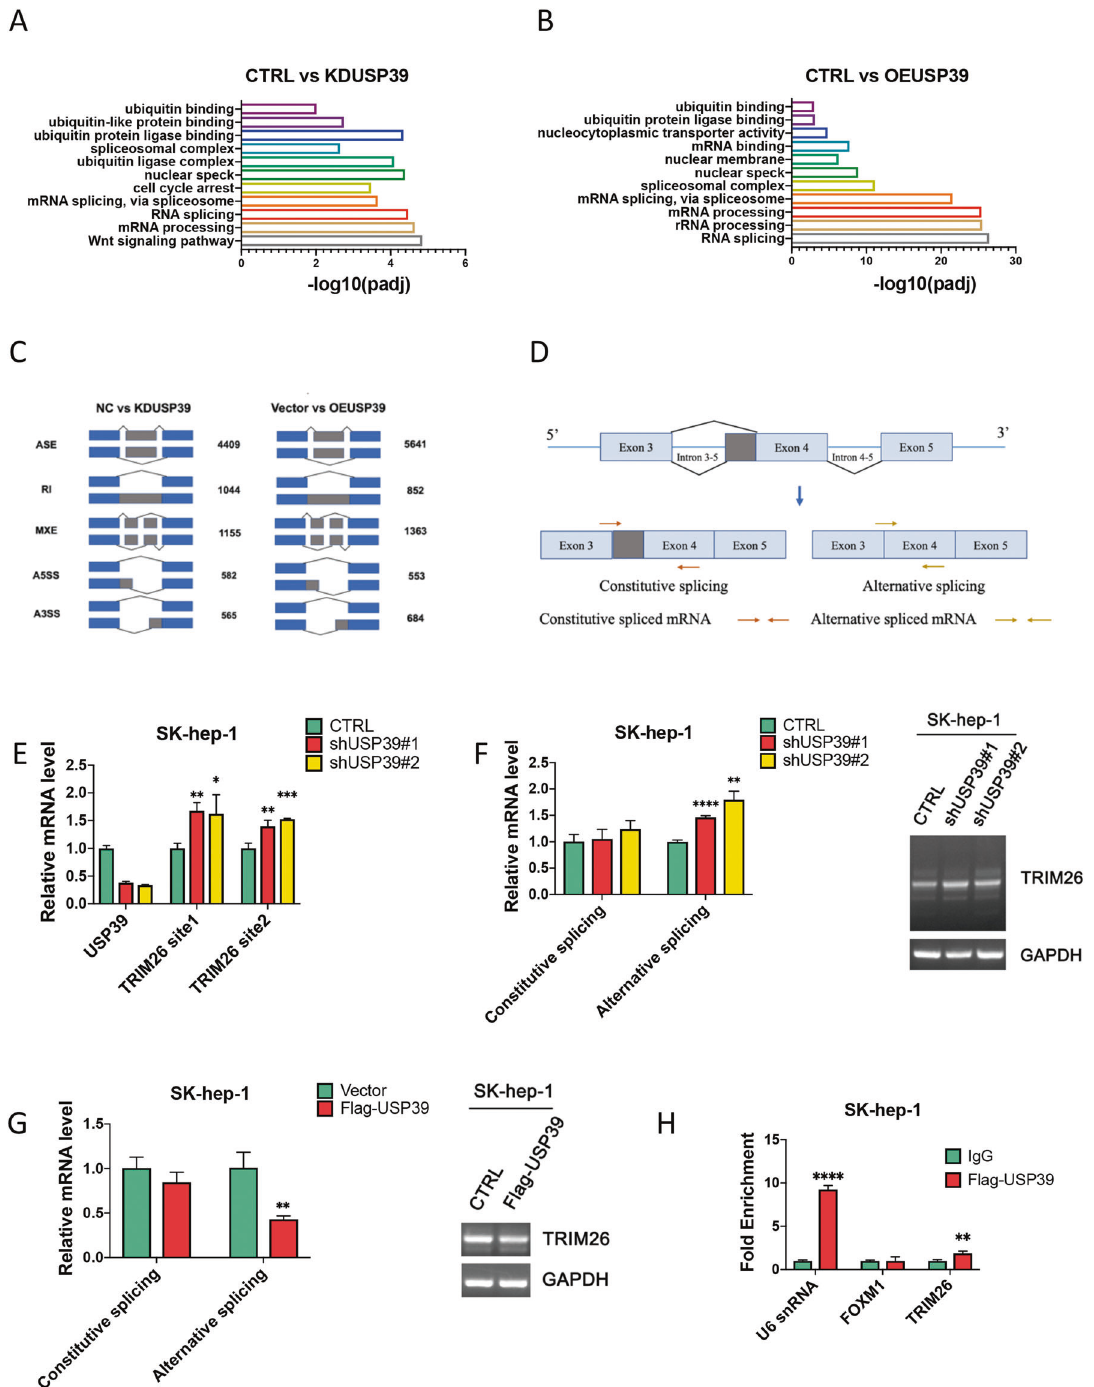
Fig. 5 USP39 was involved in the splicing of TRIM26 pre-mRNA. Enriched GO analysis that presented different functions of differentially expressed genes (DEGs) from HCT116 cells knockdown ( A ) or expressing Flag-tagged USP39 ( B ) of USP39 C Number of signi fi cant differential splicing events identi fi ed following knockdown or overexpression of USP39 in human colon cancer cells using rMATS. (ASE alternative spliced exon, RI retained intron, MXE mutually exclusive exon, A5SS Alternative 5 splice site, A3SS Alternative 3 splice site.) D Schematic model representing the fourth exon region of TRIM26 selected for ampli fi cation experiments to detect constitutive and alternative spliced RNA transcripts using qRT-PCR. The speci fi c primers designed are indicated by two pairs of arrows, indicating their approximate positions. E knockdown of USP39 in SK-hep-1, qRT-PCR was used to detect TRIM26 mRNA expression levels. F qRT-PCR was used to detect the expression of constitutive spliced and alternative spliced RNA transcripts in SK-hep-1 cells following the knockdown of USP39. G Overexpression of USP39 in SK-hep-1 cells, qRT-PCR was used to measure the levels of constitutive spliced and alternative spliced RNA transcripts. H RIP assay con fi rmed that USP39 binds to the mRNA of TRIM26. U6 snRNA and FoxM1 represented positive and negative control. All the data are representative of at least three independent experiments and presented as the means ± SD. (* p < 0.05; ** p < 0.01; *** p < 0.001; **** p < 0.0001 v.s. control by one-way ANOVA or Student ’ s t